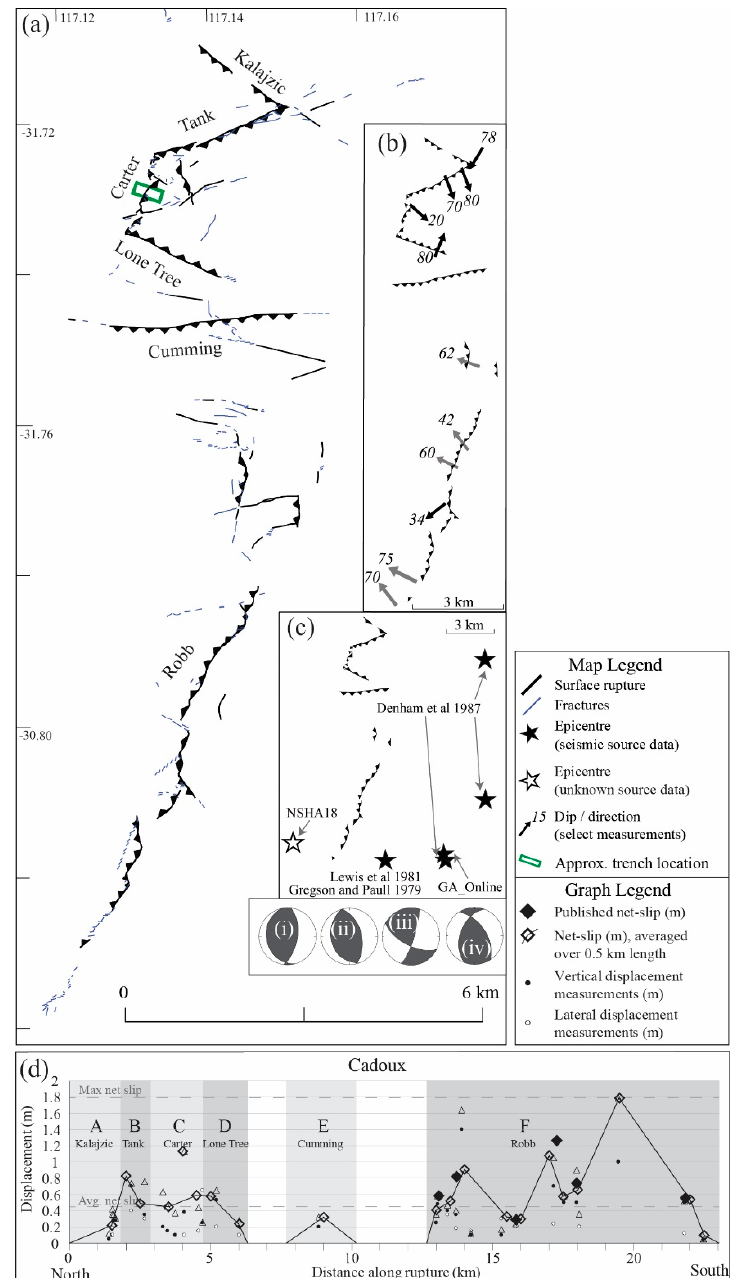
Figure 5. 1979 Mw 6.1 Cadoux earthquake (a) rupture scarps and fracturing involved in the Cadoux rupture with named faults [41], focal mechanisms from (i) Denham et al., 1987 (ii) Fredrich et al., 1988 (iii) Everingham and Smith (unpublished, Lewis et al., 1981) (iv) CMT (b) available dip measurements, black where directly measured and grey were calculated based on available displacement measurements [41] (c) published epicenter locations (d) graph along-rupture of vertical and lateral displacement measurements and calculated net slip [41] and net slip calculated from available data averaged over 0.5 km increments (this study). The previous Figure 5D with incorrect net-slip values was: